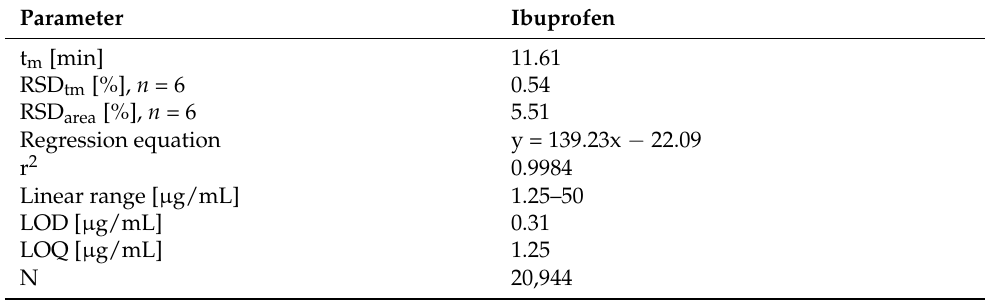
Table 2. Selected operation and calibration parameters of the CZE-UV method. Table 3. Accuracy and precision of the developed CZE-UV method from analysis of QC samples. QC